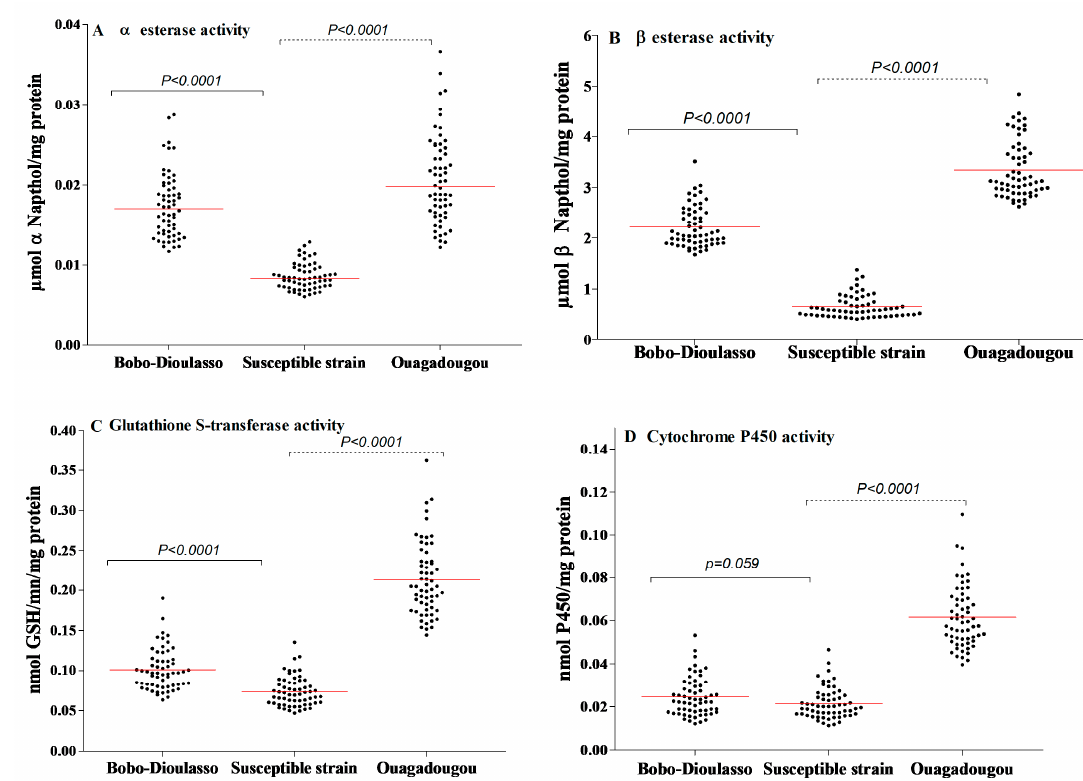
Figure 3. Detoxifying enzyme activities in Aedes aegypti mosquitoes collected in Bobo-Dioulasso and Ouagadougou in 2016. ( A ) Non-specific α Esterase activity, ( B ) PPNA activity, ( C ) glutathione-S-transferase (GST) activity, ( D ) P450 activity. P-value denotes significant difference in activity level when compared to the Ae. aegypti (from Montpellier) reference strain according to the Mann–Whitney U test. Red bars indicate the median value in each strain.